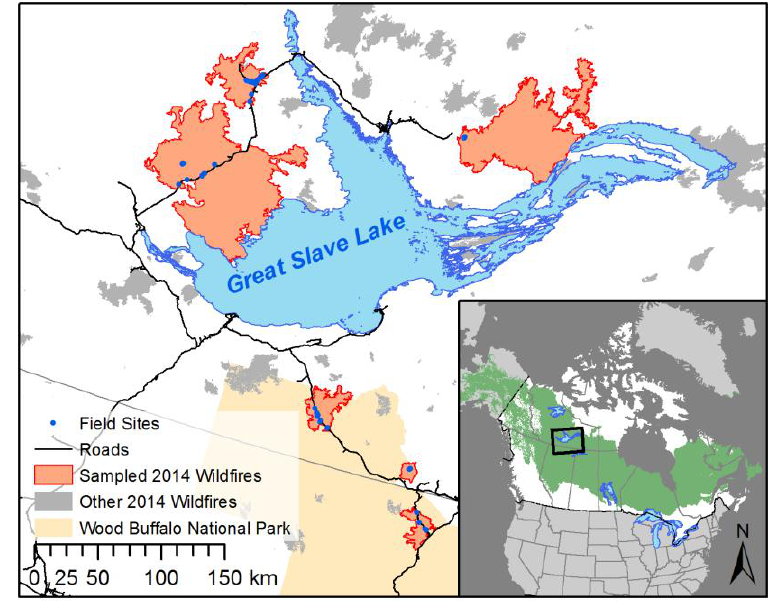
Figure 1. The sampled 2014 wildfires and field site locations in the Northwest Territories and Wood Buffalo National Park. The study area is indicated in black on the inset map, within the context of the North American boreal forest (shown in green) [47].